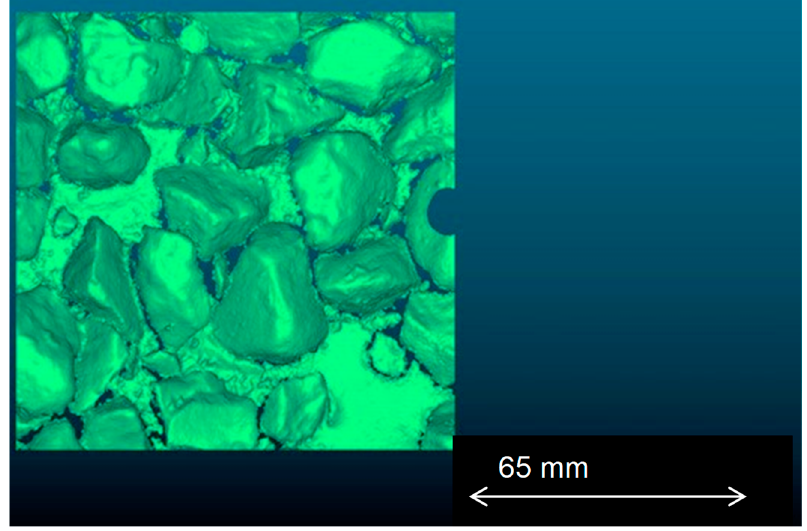
Figure 7. Typical example of an imported mesh of the 20 mm single